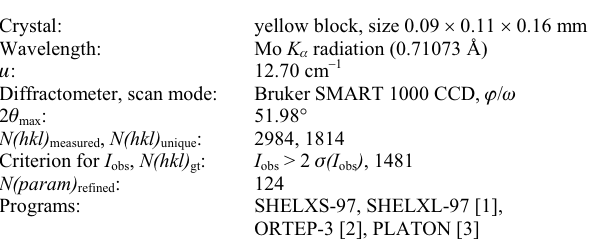
Table 1. Data collection and handling.